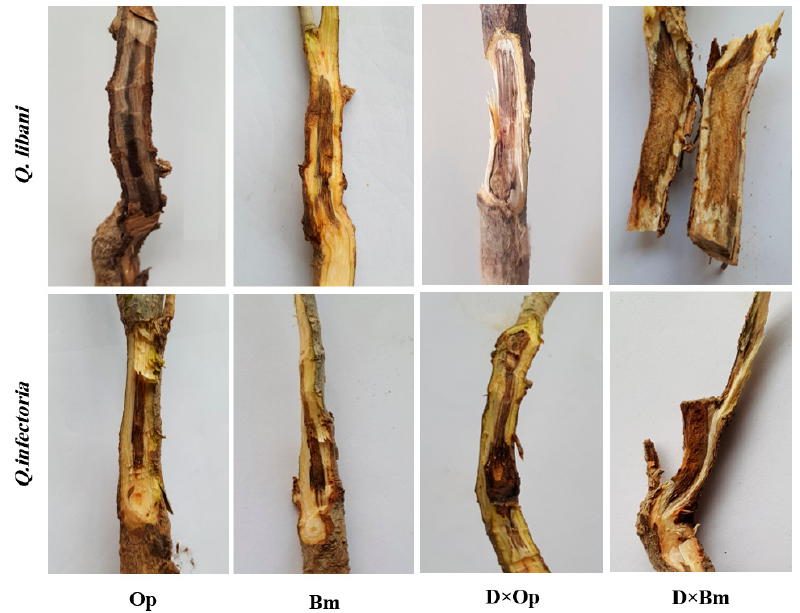
Figure 1. Longitudinal cross section of Quercus libani and Q. infectoria seedling shoots subjected to charcoal disease pathogens, drought and their interaction. Op: Obolarina persica , Bm: Biscogniauxia mediterranea , D × Op: Drought × O. persica and D × Bm: Drought × B. mediterranea .